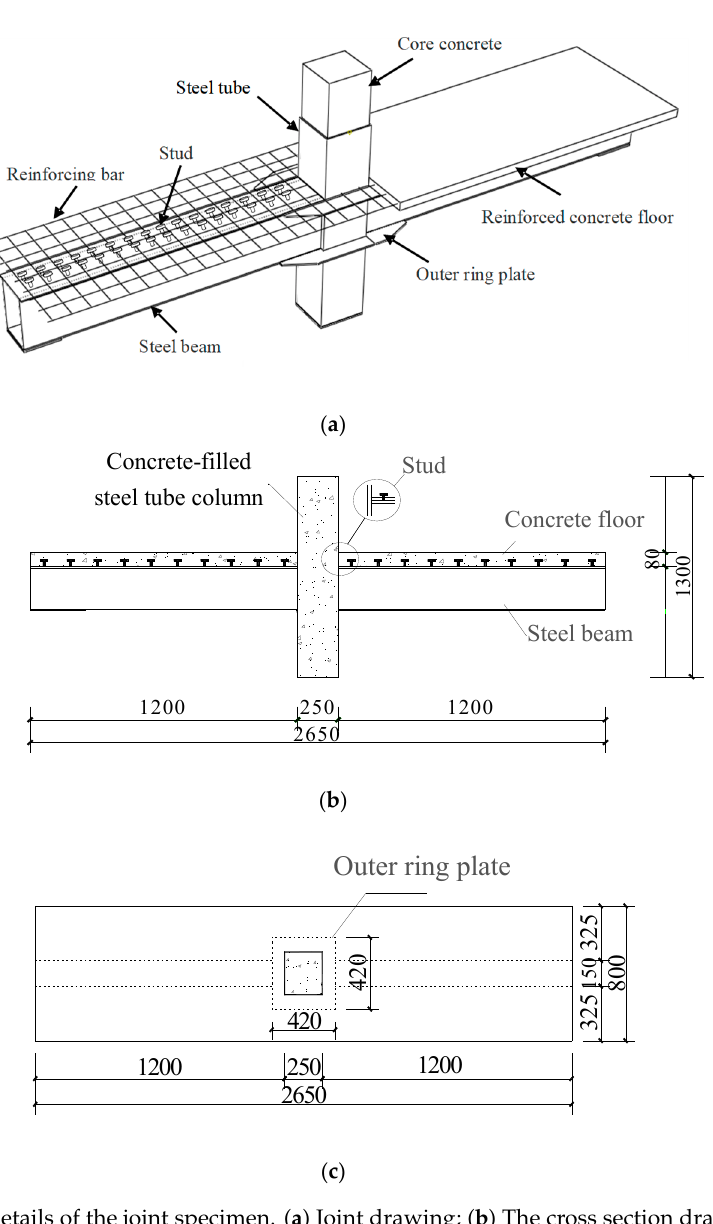
Figure 5. The details of the joint specimen. ( a ) Joint drawing; ( b ) The cross section drawing of joint; ( c ) The vertical view of joint.